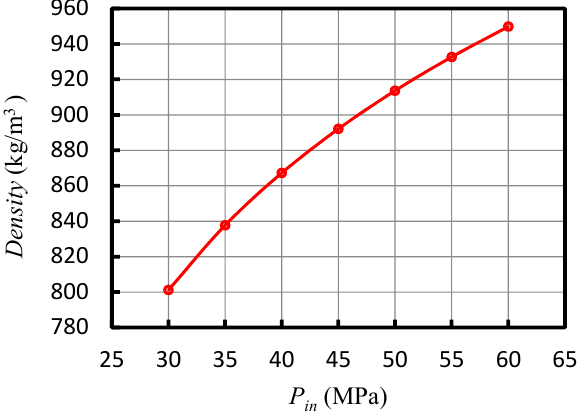
Figure 11. The density of SC-CO 2 fluid versus nozzle inlet pressure (Data from REFPROP).